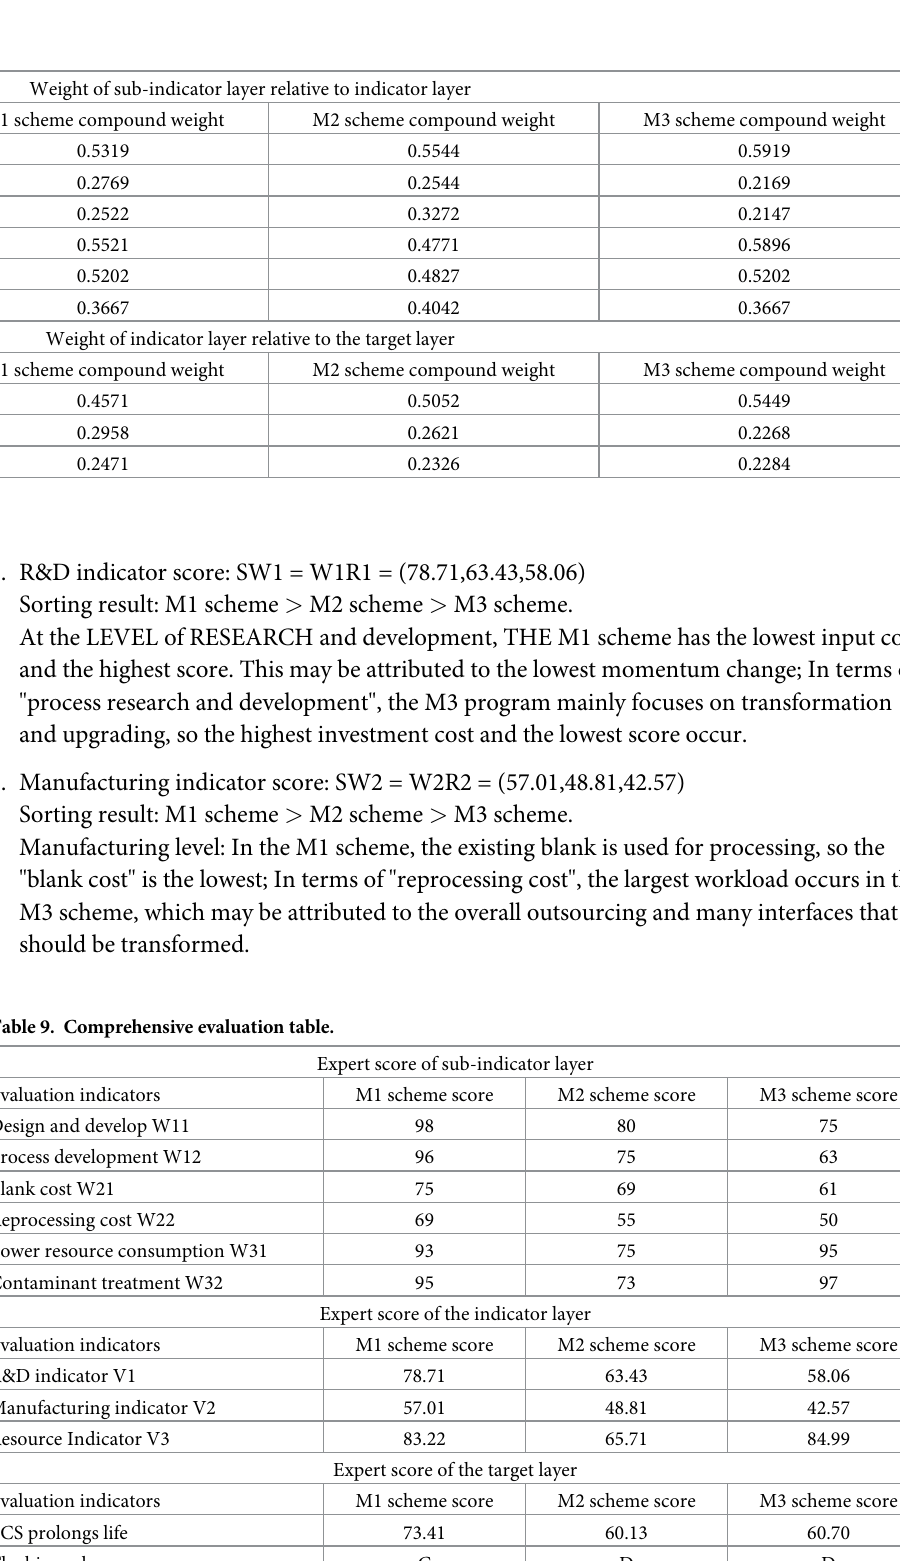
Table 8. Compound weight matrix.